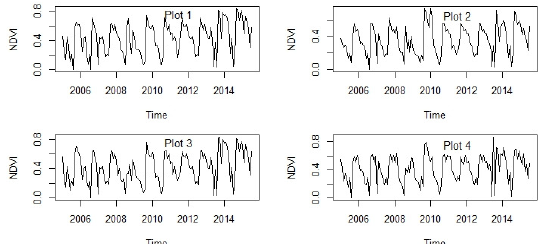
Figure 5. Gap filled NDVI time series of selected citrus plots